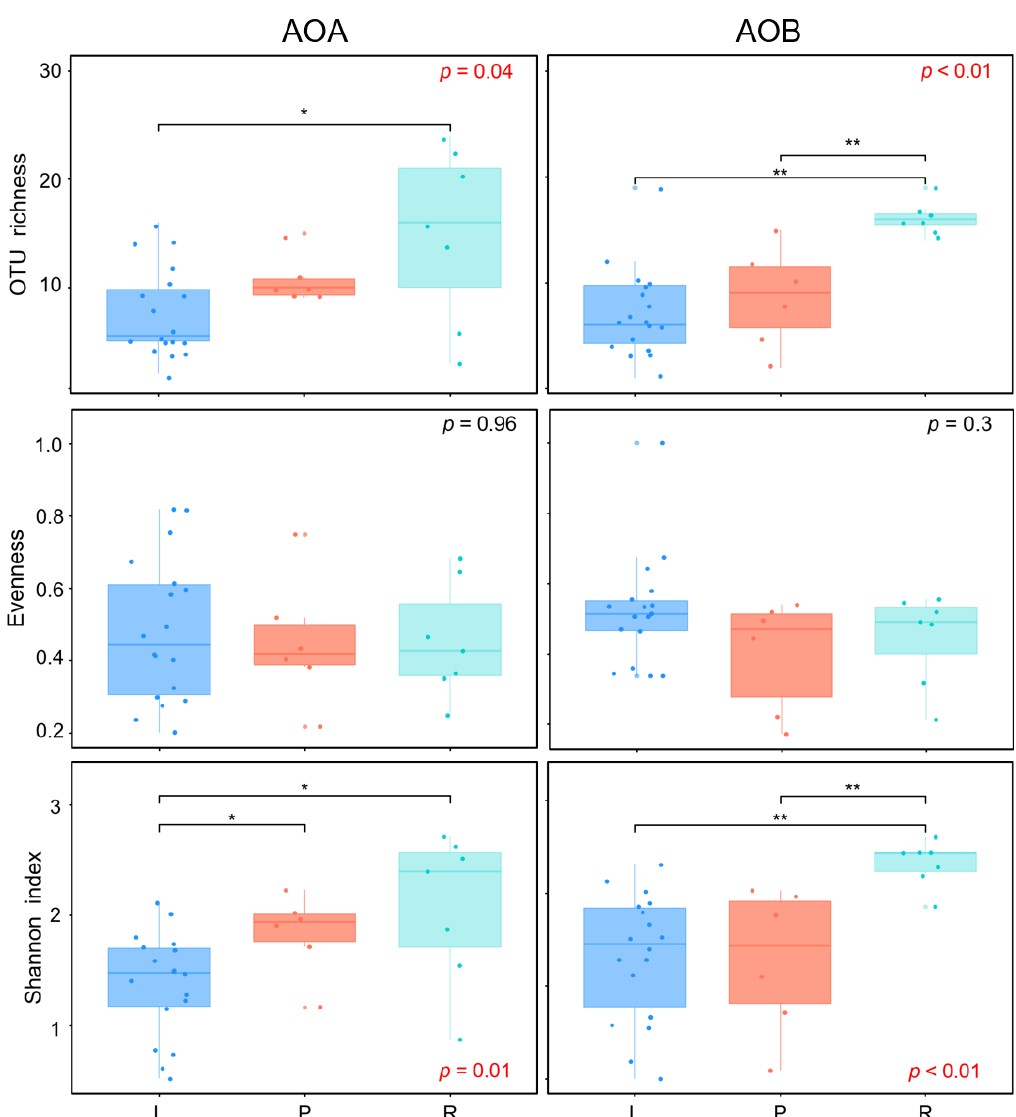
Figure 4. Alpha diversity of ammonia-oxidizing microbe communities in soils collected from lacustrine (L), palustrine (P), and riverine (R) wetlands. The asterisk indicates the statistically significant between two wetland types (** p < 0.01, * p < 0.05).